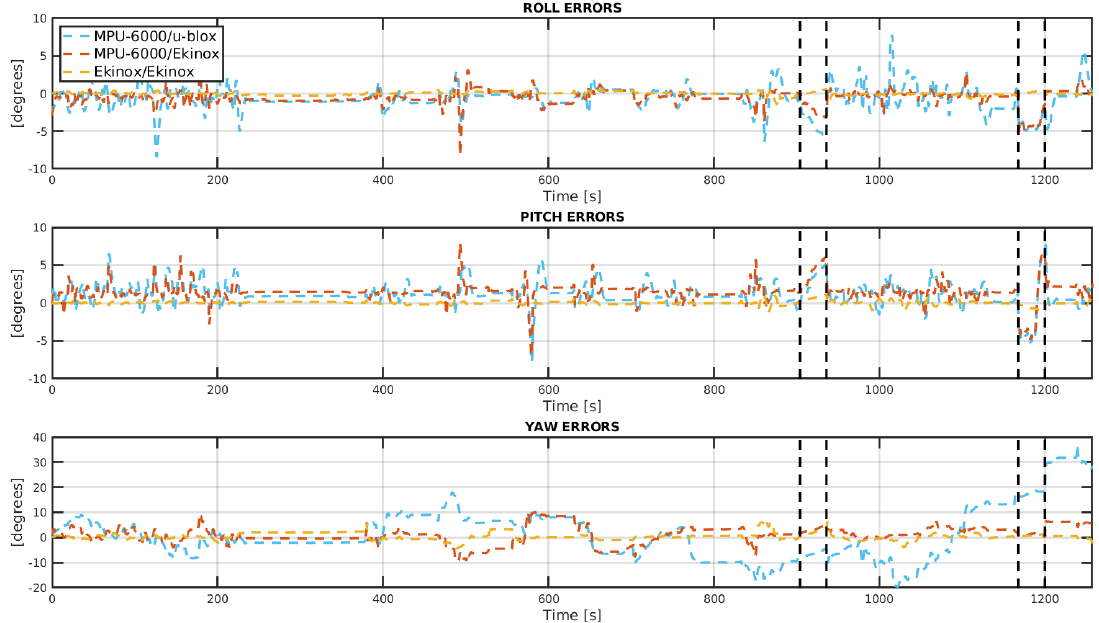
Figure 9. Attitude errors for the complete trajectory. Black vertical lines spot both GNSS-denied stretches.